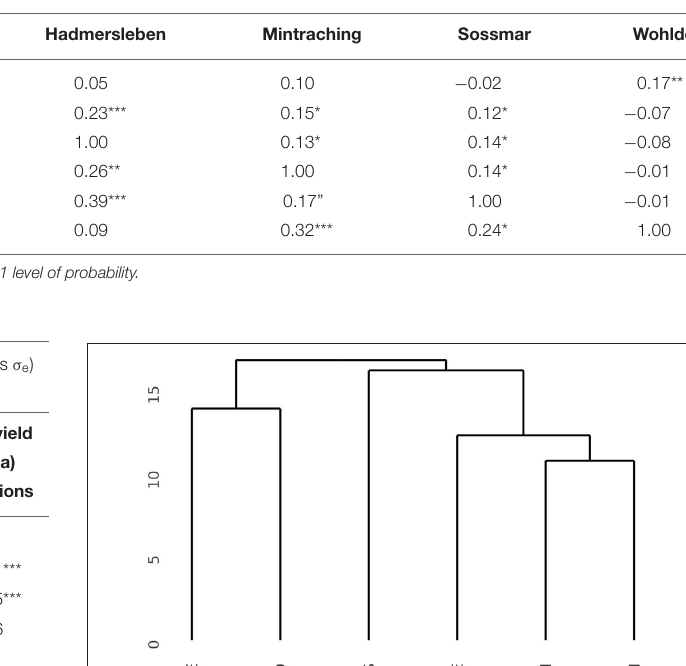
TABLE 1 | Pearson moment correlations between grain yield of 109 wheat lines (below diagonal) and 264 hybrids (above diagonal) evaluated at six locations in the year 2019 to assess the selection gain of the reciprocal recurrent genomic selection program. Inbred/hybrid Adenstedt